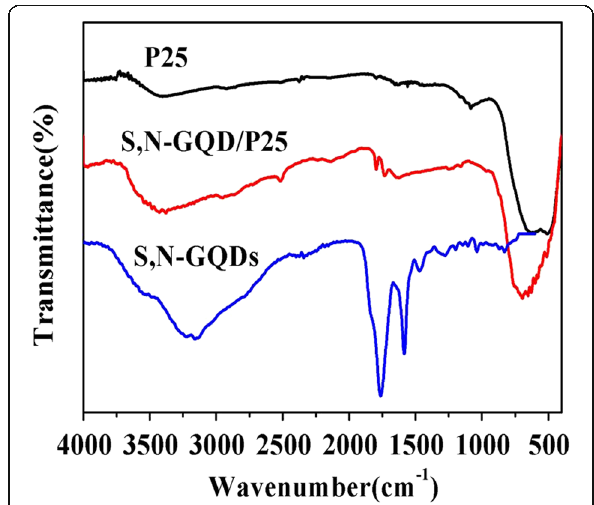
Fig. 3 FTIR spectra of P25, S,N-GQDs, and S,N-GQD/P25